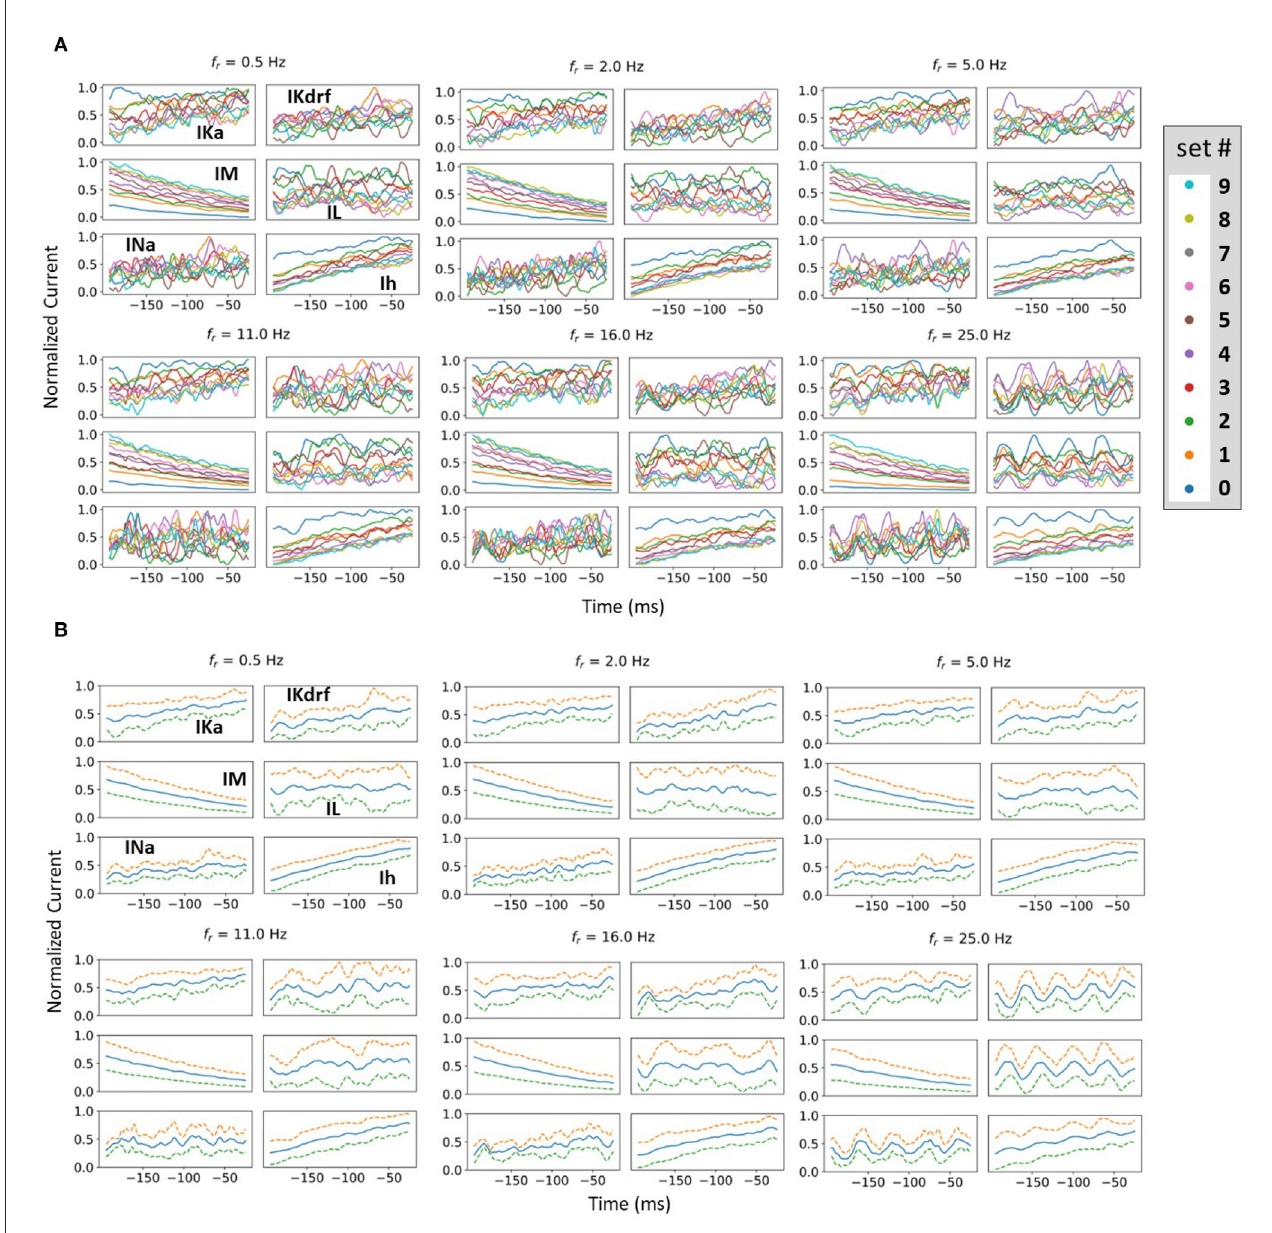
FIGURE7 Examples of normalized STA and spread analysis. (A) Examples of normalized STA plots, with different colors representing different representative sets. Set numbering is the same as in Figure 5. (B) Blue lines in the middle of the plots are the means of normalized currents from (A) . The dashed lines are standard deviation of the normalized currents from the mean. Spread is defined as the mean difference between the dashed